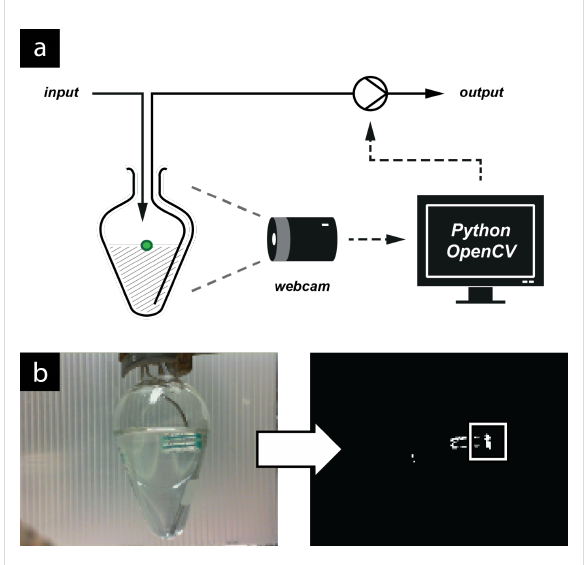
Figure 11: (a) In-line reservoir schematic. The liquid level is meas- ured by observation of a plastic float. (b) Image processing to measure the liquid level. The computer receives an image of the reservoir and processes it as follows: (1) Separate the image into red, green and blue components (“channels”) and then identify the green pixels by subtracting the red channel from the green. (2) Convert the resulting greyscale image to black and white based on a certain threshold of lightness. (3) Find the centre of the largest white region (shown high- lighted with a box) and report its height from the bottom of the